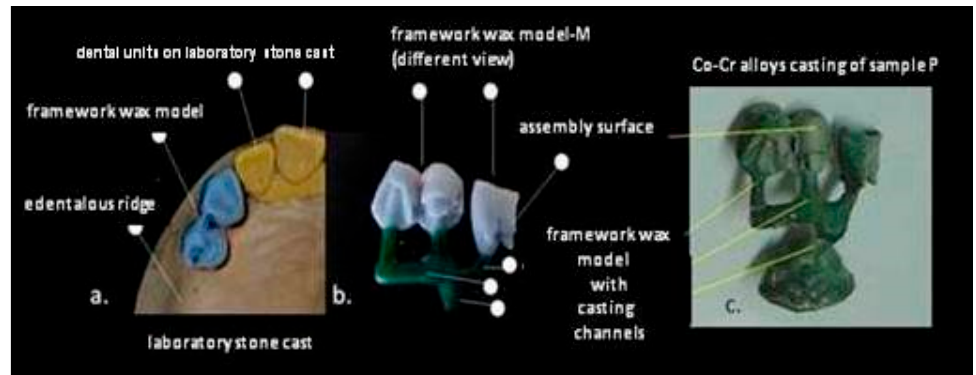
Figure 1. ( a ). Framework of structure P on the laboratory cast; ( b ). Preparation of the framework for coating and obtaining the refractory mold, by attaching the frameworks of the casting channels; ( c ). Sample P.